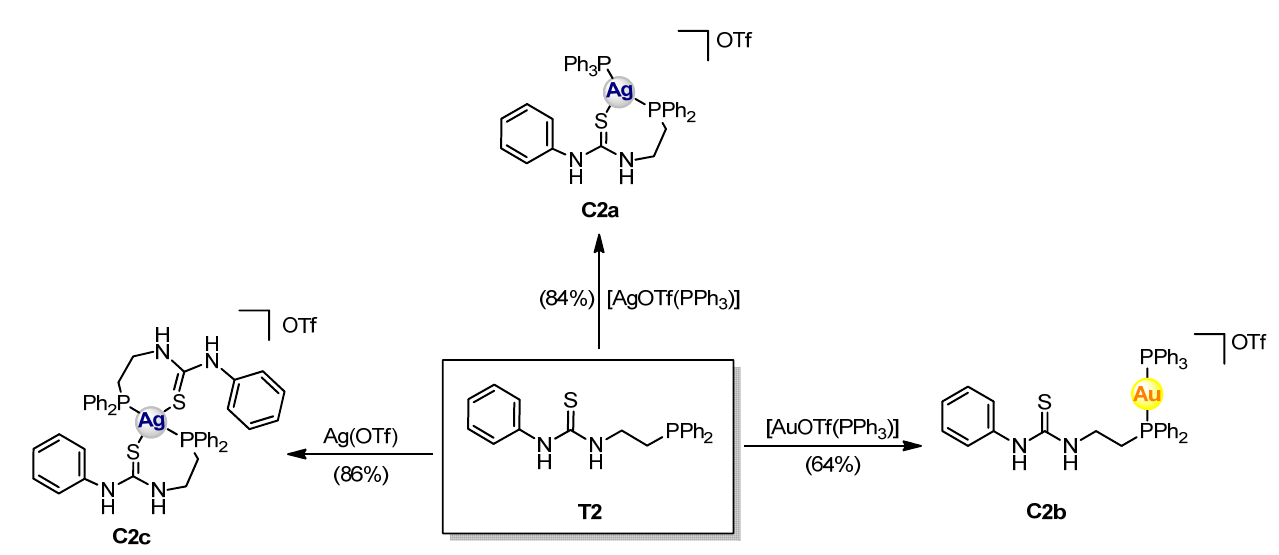
Scheme 4. Synthesis of metal complexes C2a–c derived from T2